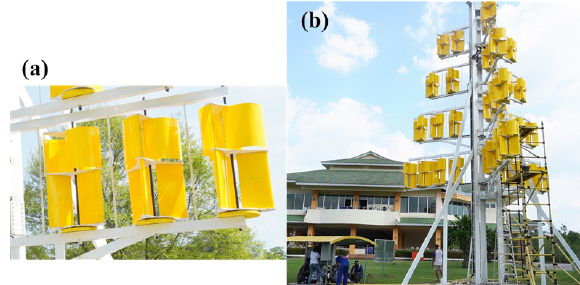
Fig. 7. VAWTs were applied for a wind farm (a) The VAWTs used the same scale when tested in the wind tunnel experiment; (b) The application of VAWTs combined 32 items for the wind farm (Rajjaprabha Dam,